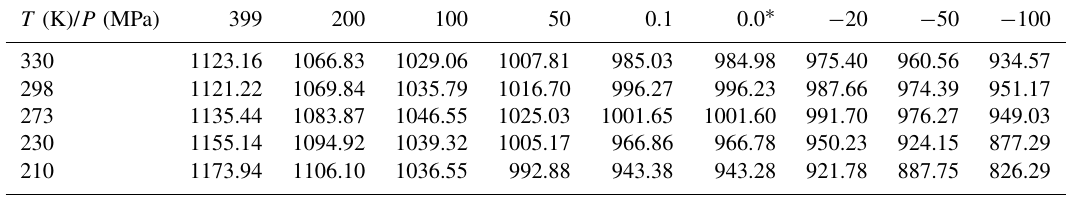
Table D1. Selected values of density ρ w (T,P) in kgm − 3 parameterized in Eqs. (A1)–(A5).